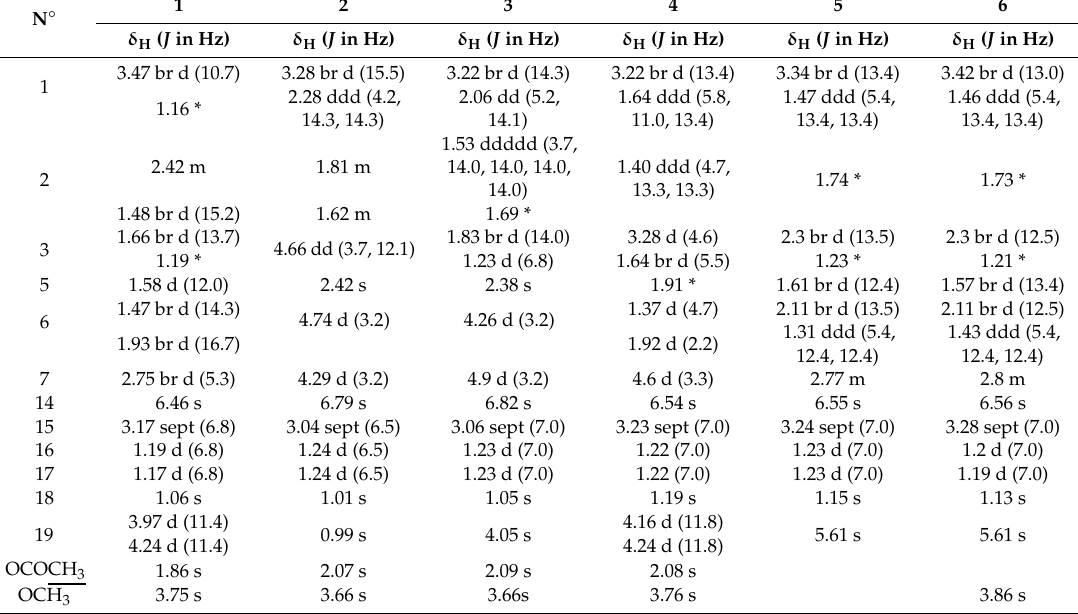
Table 1. NMR spectroscopic data assignments (400 MHz) for compounds 1 – 6 ( δ in ppm, m, J in Hz) in CDCl 3